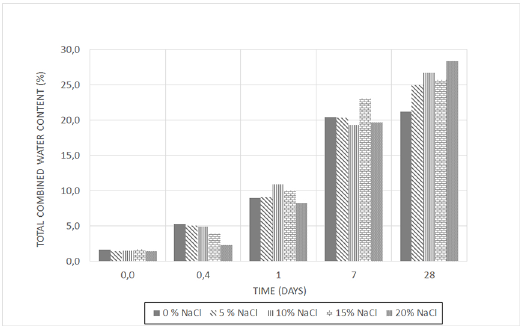
Figure 8. Total combinated water content for samples with different percentages of NaCl in its hydration water.